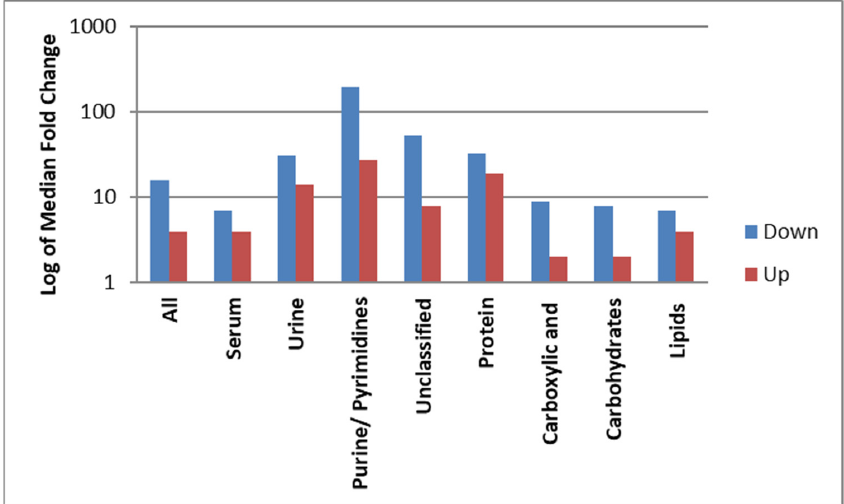
Figure 3. Magnitude of dysregulation. The magnitude of the downregulation of the metabolites after surgery was higher in both the serum and urine samples ( p = 0.043); although this was not statistically significant, the difference was larger in the urine samples ( p = 0.28) than the serum samples only ( p = 0.69). The alteration in purines/pyrimidines ( p = 0.045) and protein and derivatives ( p = 0.027) was larger than those in the other classes of metabolites.